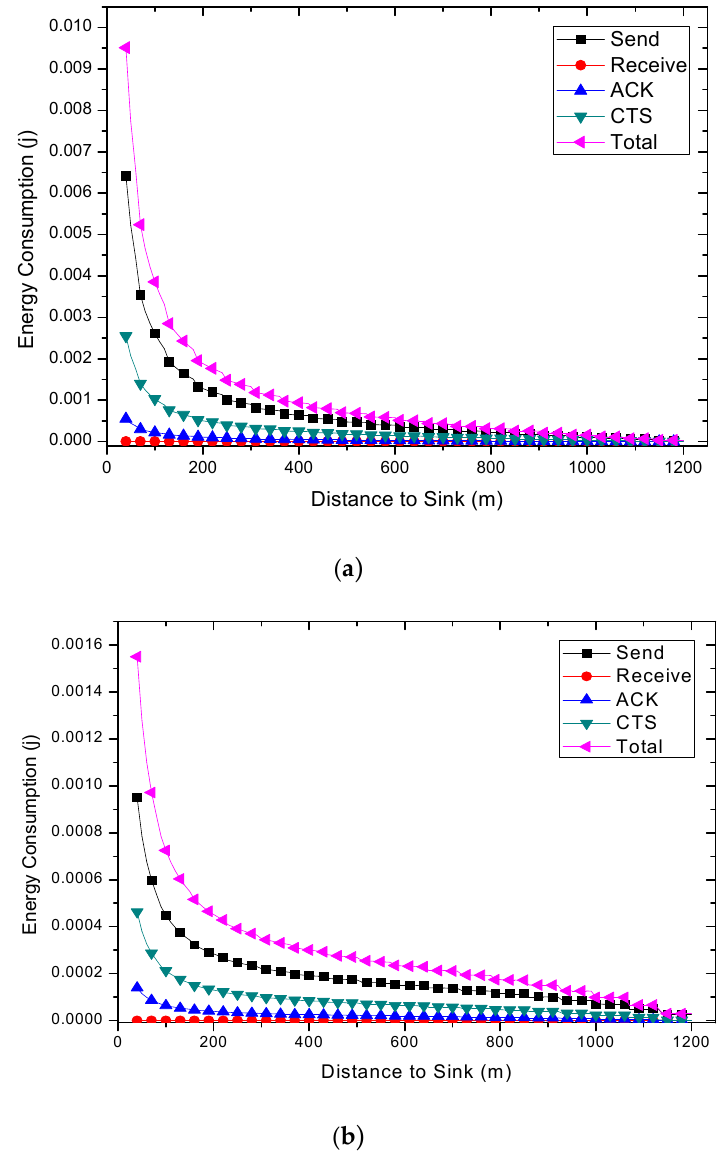
Figure 12. ( a ) Energy consumption of node under N = 3, r = 60; ( b ) Energy consumption of node under N = 3, r = 70.